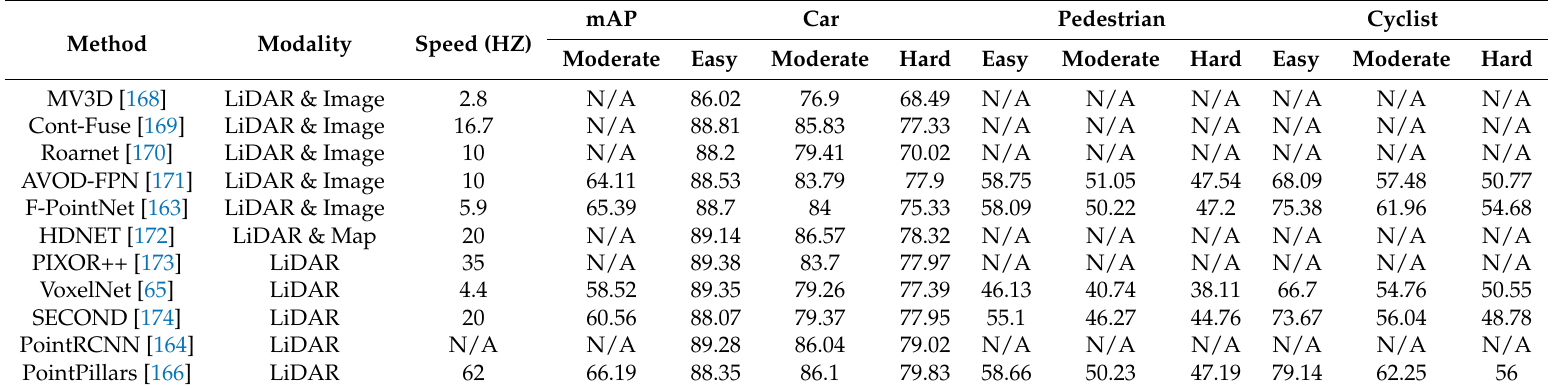
Table 7. Performance on the KITTI Bird’s Eye View detection benchmark.